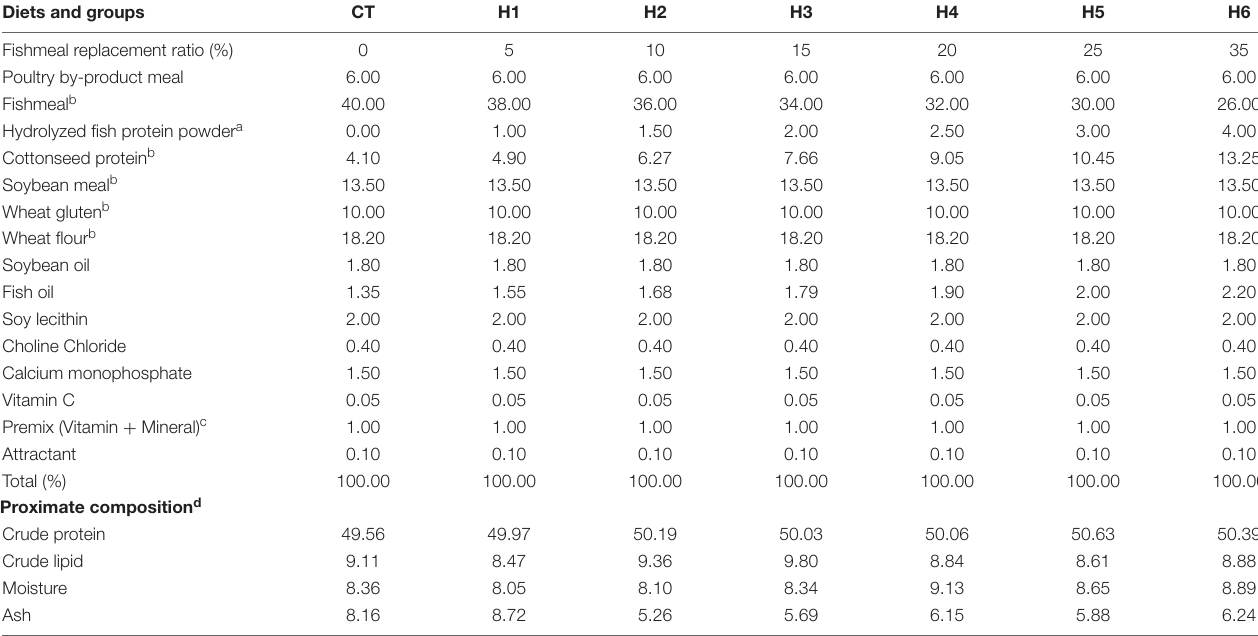
TABLE 2 | Formulation and nutrient composition of the experimental diets (% dry